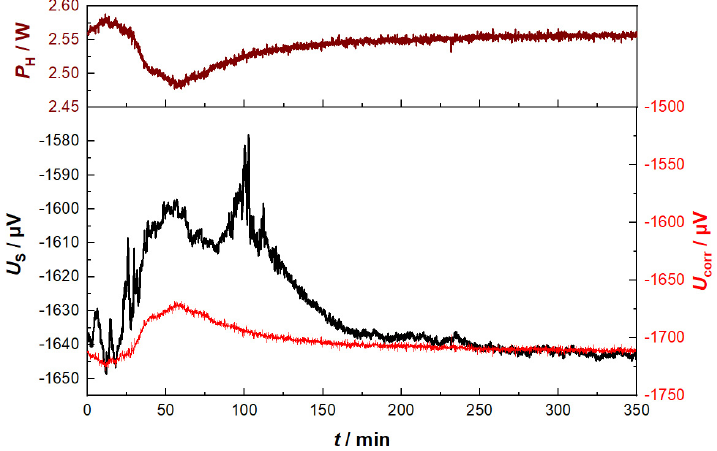
Figure 6. Sensor raw signal, U s , and heating power, P H , as calculated from the sensor heater data during the charge combustion cycle (corresponding flue gas analysis data are shown in Figure 5). From the heater power, an offset voltage was derived ( U corr ) to correct the raw data.